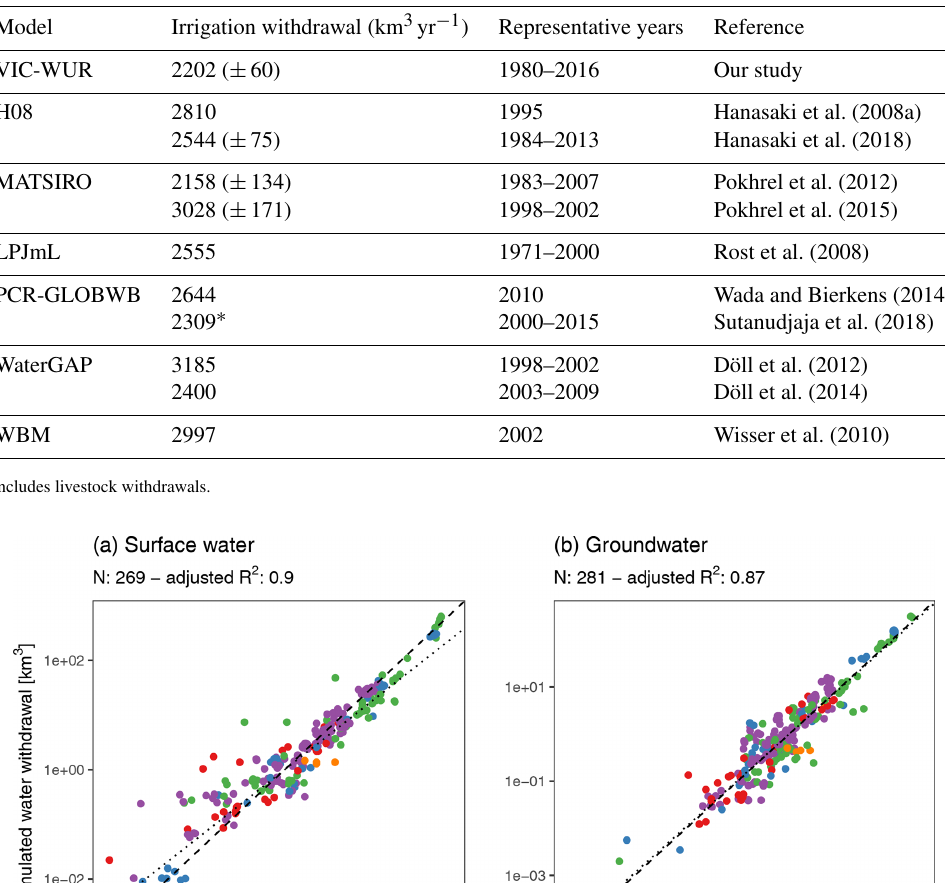
Table 1. Average annual global irrigation water withdrawals as calculated by several global hydrological models.